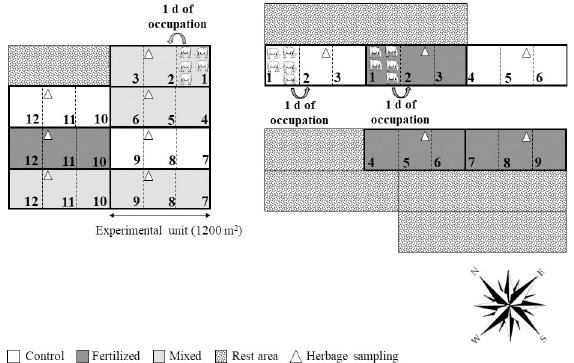
Fig 2. Schematic representation of the experimental design. Three treatments with four replications, arranged in a completely randomized design. Experimental unit of 20 × 60 m (1200 m 2 ). Control: Marandu palisadegrass in a monoculture (without N fertilizer or legume); Fertilized: Marandu palisadegrass fertilized with 150 kg N ha -1 year -1 (urea split into three equal applications); and Mixed: Marandu palisadegrass mixed with forage peanut cv. Amarillo and no N fertilizer. Intermittent stocking method with grazing periods lasting 3 d, or 1 d for each paddock. Palisadegrass pasture was used as a reserve area to hold the animals during the rest